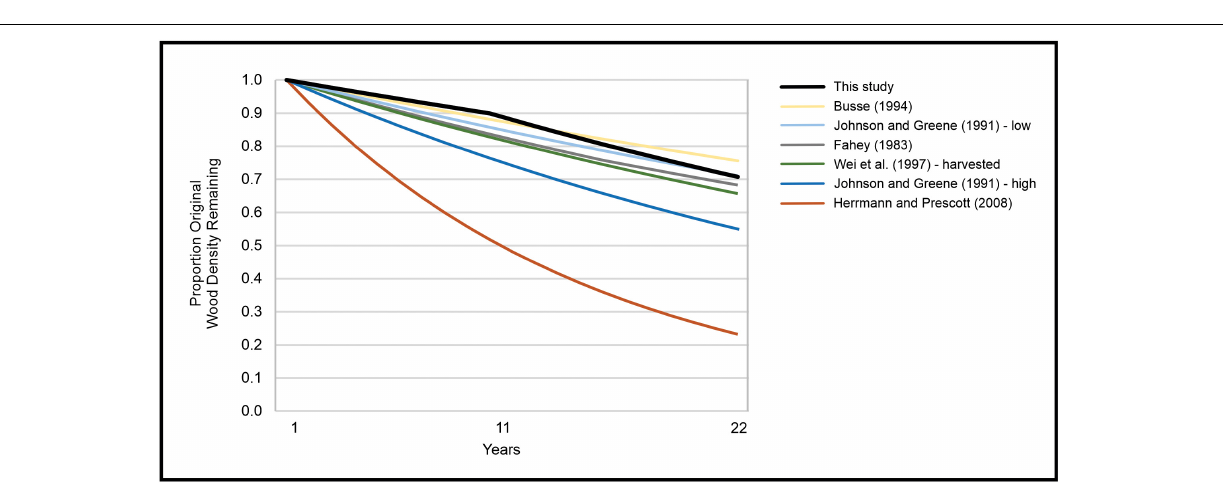
FIGURE 3 | Comparison of the proportion of wood density remaining in this and referenced studies using the published decay rates over a 22-year period. The 11 Yr and 22 Yr decay rates from this study are graphed for the appropriate periods. Johnson and Greene (1991) published high and low rates. The decay rate from Wei et al. (1997) is for material sampled on harvest